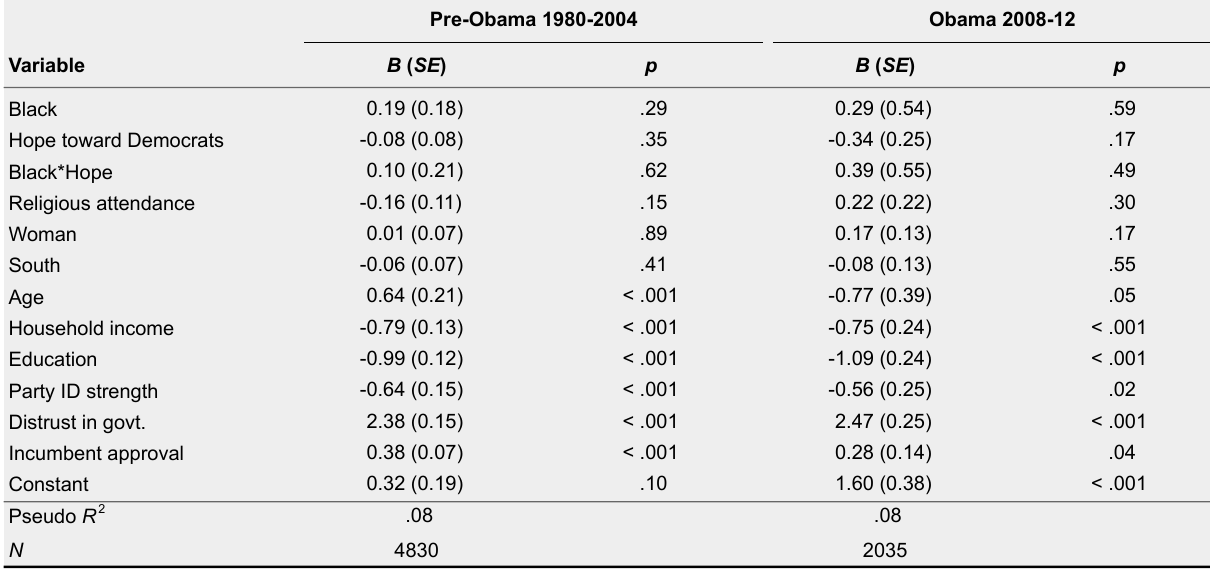
Logit Models Interacting Race and Hope Toward Favored Partisans on Democrats’ Reported External Efficacy, Across Pre-Obama and